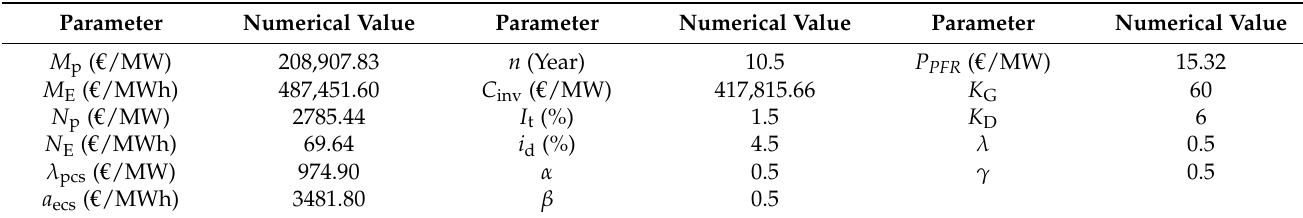
Table 4. Parameter values of capacity optimization model in peak and frequency modulation